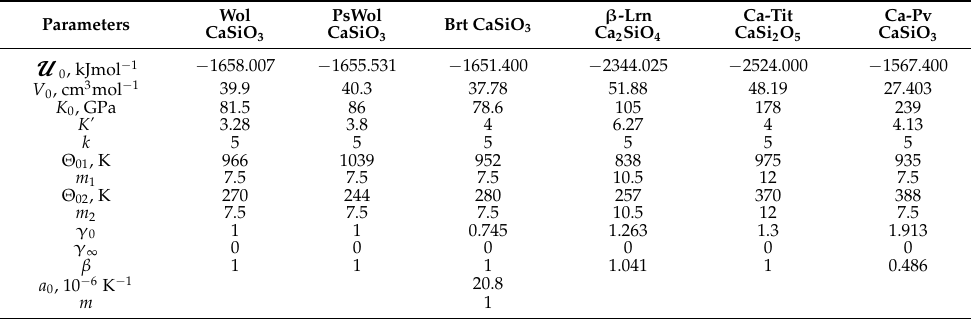
Table 1. Parameters of equations of state of Ca-silicates at ambient conditions. Parameters